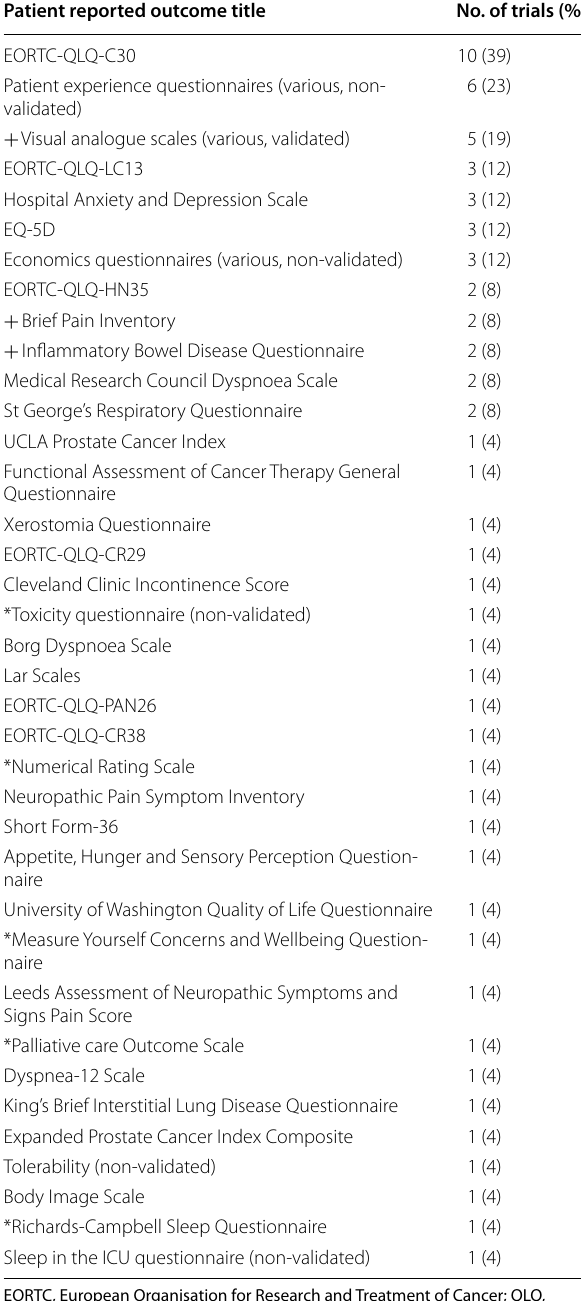
Table 2 List of PRO measures used (n